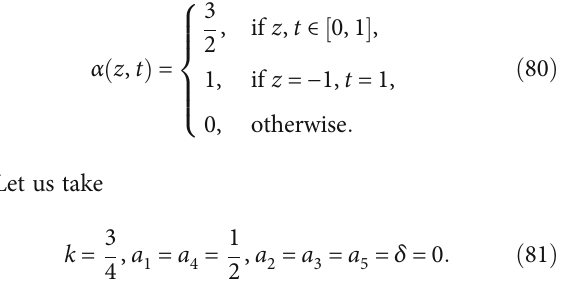
ffiffiffiffiffiffiffiffiffiffiffiffiffiffiffi z 2 − t 2 j ffiffiffiffiffiffiffiffiffiffiffiffiffiffiffiffiffiffiffiffiffiffiffi ffiffiffiffiffiffiffiffiffiffiffiffi z − t j